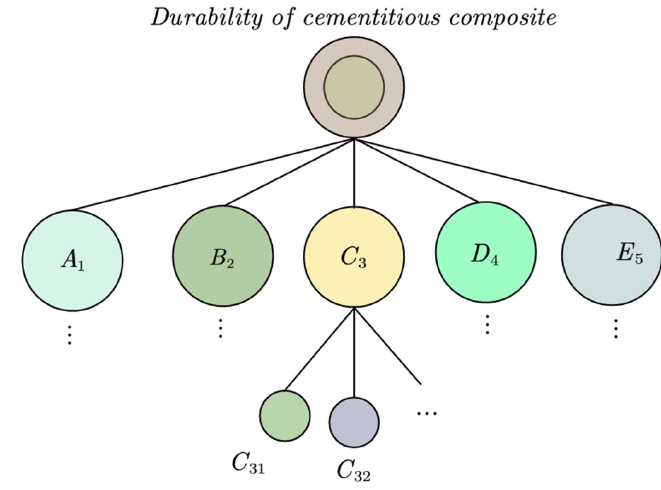
Figure 2. Tree network topology of composite durability evaluation.